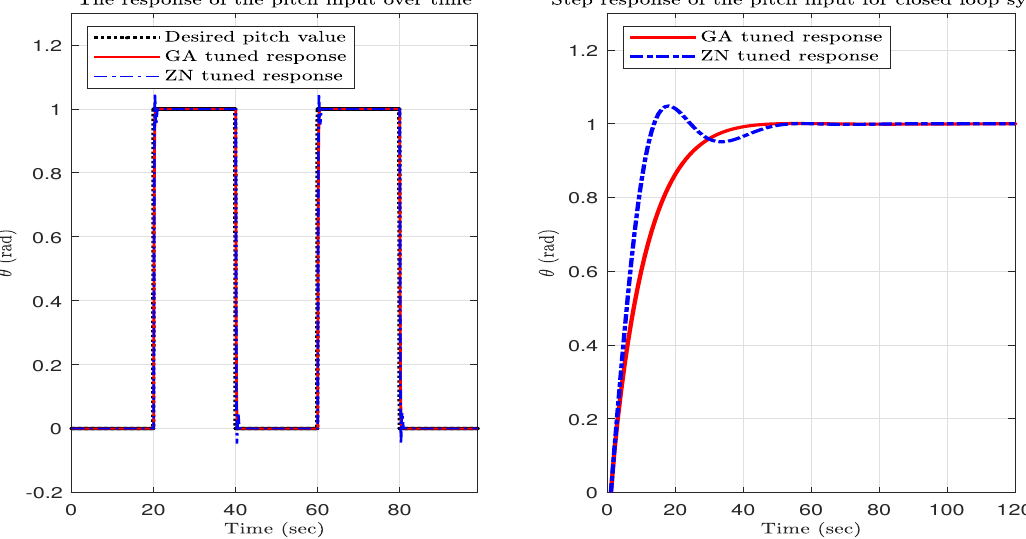
Figure 8. Simulated output response of the pitch input of a quadcopter using GA and ZN methods.